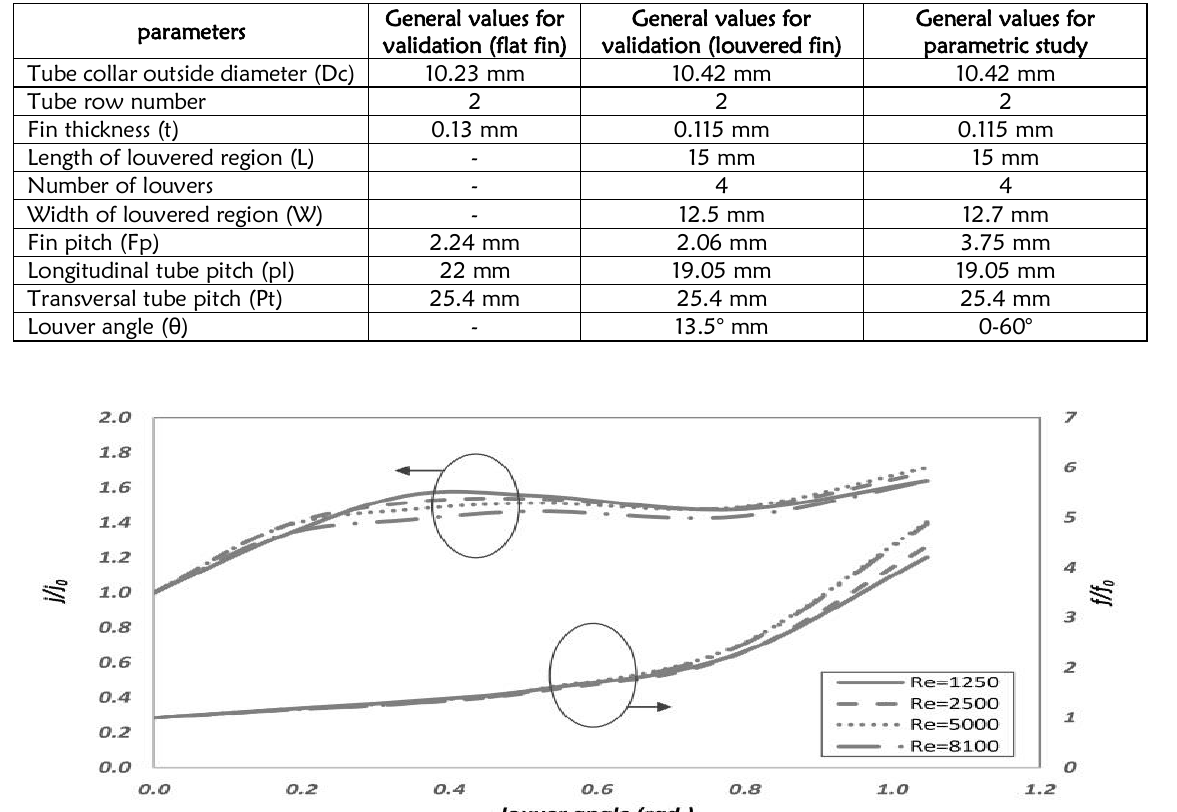
Table 1: General Geometric Parameters of Simulated Louvered Fin [5].